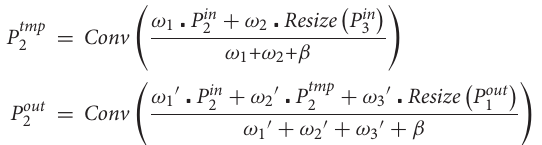
Some instances may be as small as 0.01% of an image, while others can be more than 40%. The distinct differences between the model must be flexible enough in order to deal with extremely depicts the statistics of the scale of an instance in its image.